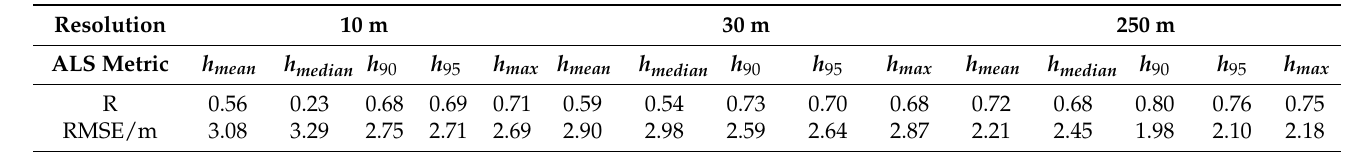
Table 3. The calculated R and RMSE for ICESat-2 ATL08 product and metrics derived from ALS data at different spatial resolutions.